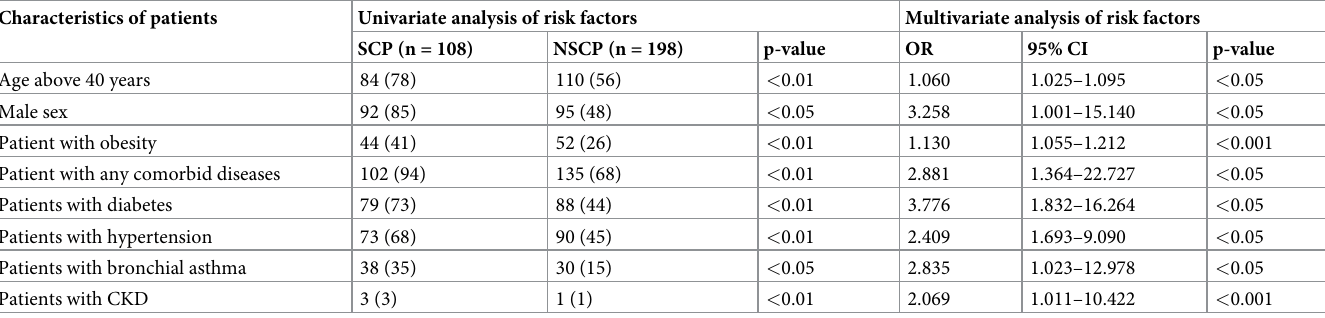
Table 4. Univariate and multivariate analysis of risk factors associated with COVID-19 severity. Characteristics of